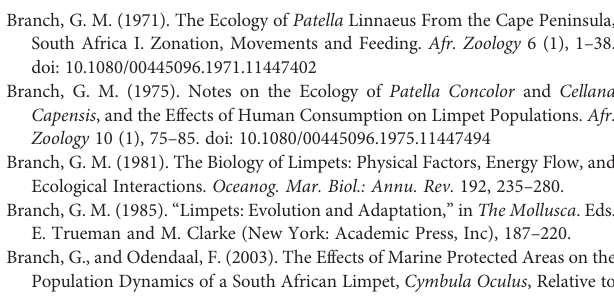
Supplementary Figure 1 | P. aspera . Second test to study the in fl uence of different alkaline baths on the larval production. Treatments combined